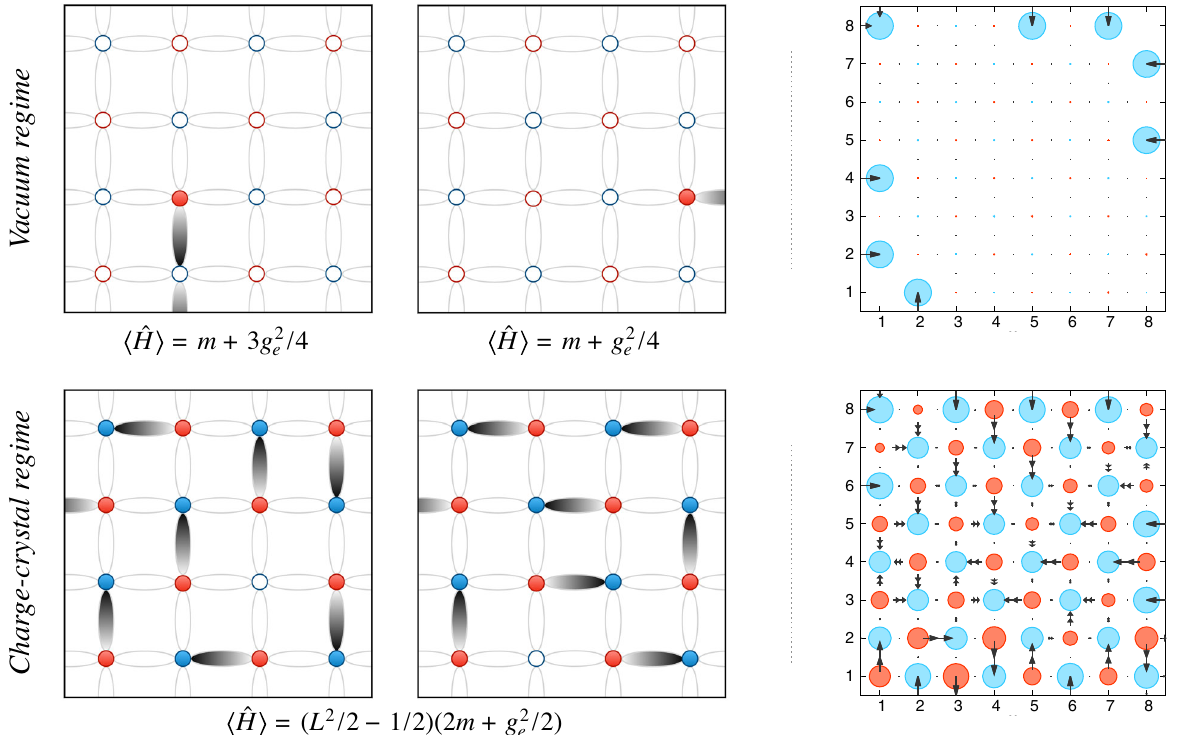
FIG. 7. Field plots in the finite charge density sectors. The top row refers to the vacuum regime and the bottom row to the charge- crystal regime. On the left of the figure, the four panels represent a sketch of the classical configurations (i.e., t ¼ 0 ) for a 4 × 4 system with open boundary conditions in the Q ¼ 1 charge sector. Gauge fields can now exit the system at the energy cost of a half-link each the system at the cost of the half-link. The panels on the right of the figure are the field plots obtained by numerical TTN simulations in 8 × 8 = 2 ¼ 2 and m ¼ 4 (top) or m ¼ − 2 (bottom), and charge sector Q ¼ − 8 . In the vacuum systems for the two different regimes, namely, g 2 e regime, the excess of charge prefers to be localized at the boundaries since such configurations are more energetically favorable. In the dimerized regime, the holes may occupy any position since the system can reconfigure the pairs of dimers so as to always use the same amount of energy. However, because of the very high degeneracy of the low-energy sector, the TTN simulations may get stuck in a slightly asymmetric